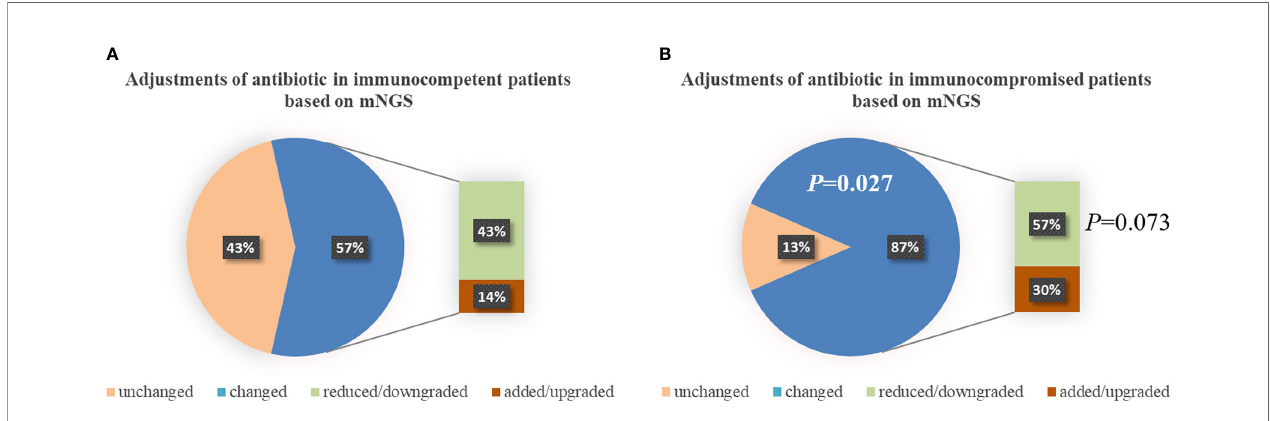
FIGURE 4 | Adjustments of antibiotic in immunocompetent (A) and immunocompromised (B) patients. Compared to immunocompetent patients, immunocompromised patients had more antibiotic treatment adjustments (87% vs. 57%, P =0.027). There was a trend of reduced/downgraded antibiotic adjustments in immunocompromised patients compared to immunocompetent patients (57% vs. 43%, P =0.073), though there was no signi fi cant difference. mNGS, metagenomic